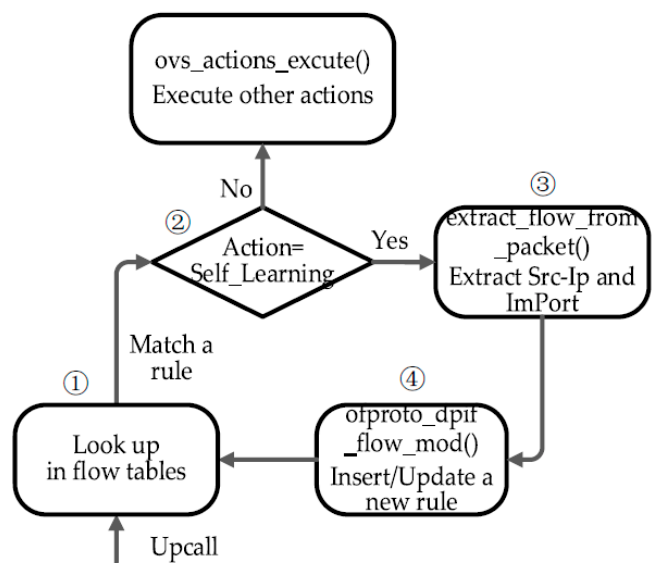
Figure 5. Self-learning module. Step 1 is to make packets match against rules in flow tables. Step 2 is to judge whether or not the rule’s action is Self_Learning. Step 3 is to extract Src-Ip and ImPort from the packet’s header. Step 4 is to insert/update a new rule according to the information extracted.